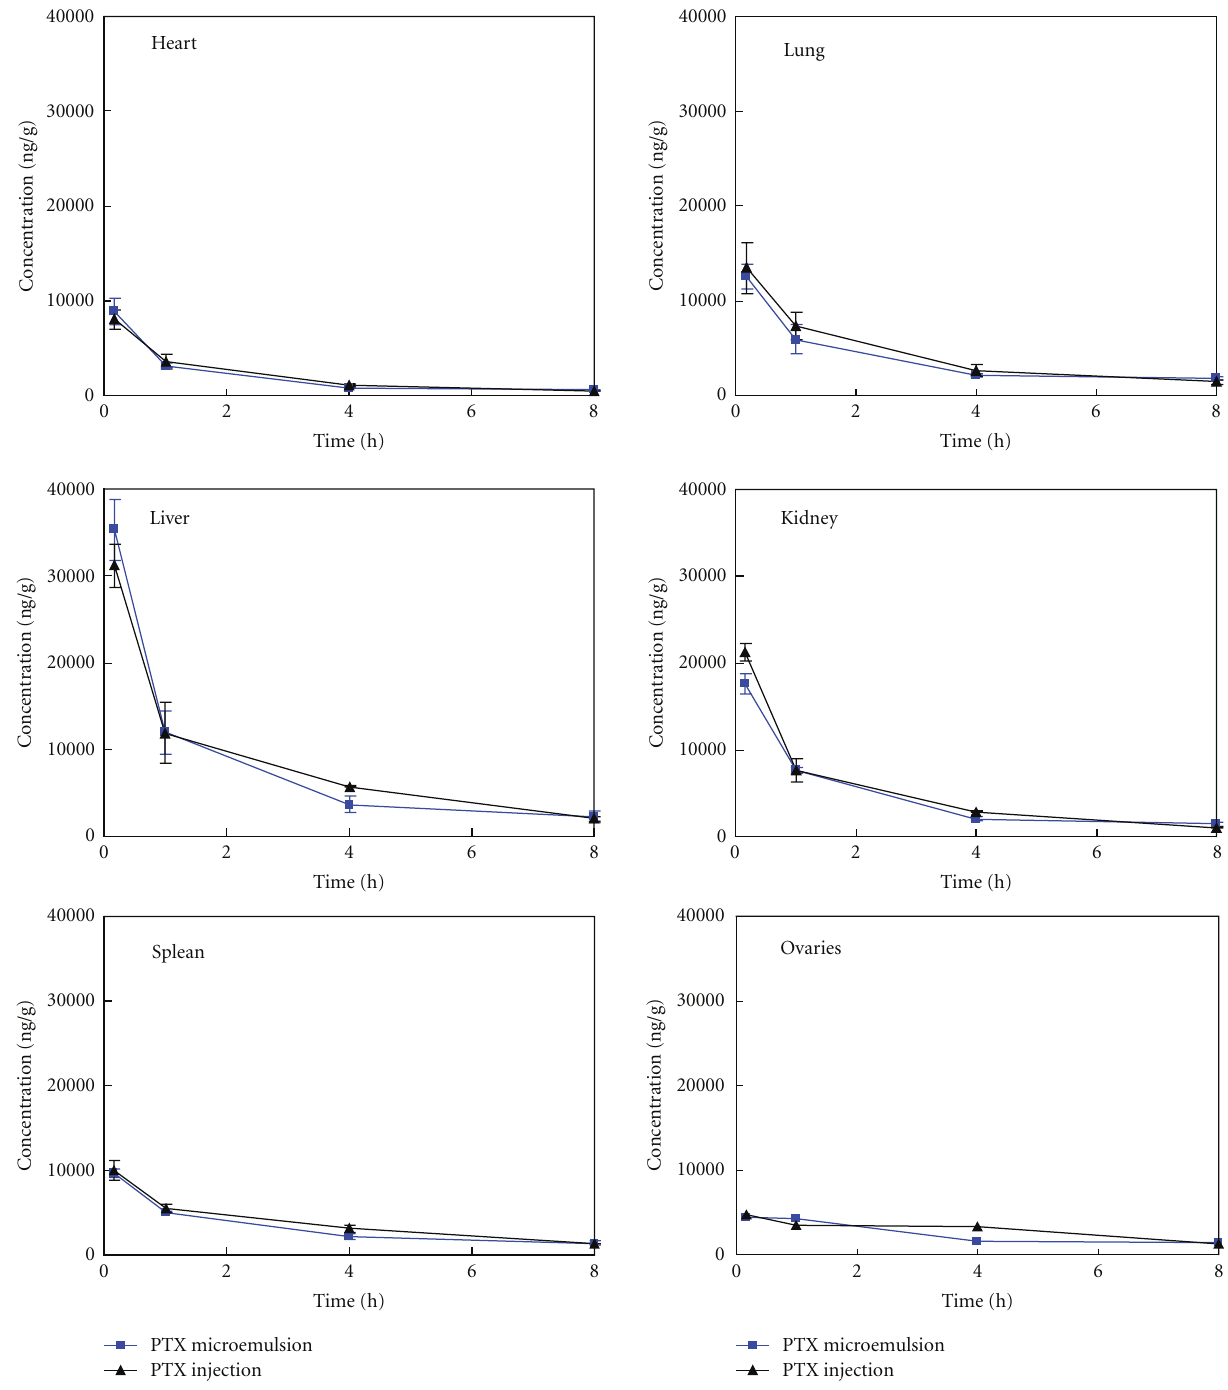
Figure 3: The tissue distribution profiles of PTX in PTX microemulsion and PTX injection after intravenous administration of PTX microemulsion or PTX injection at 5 mg/kg PTX in SD rats (means ± S.D., n =